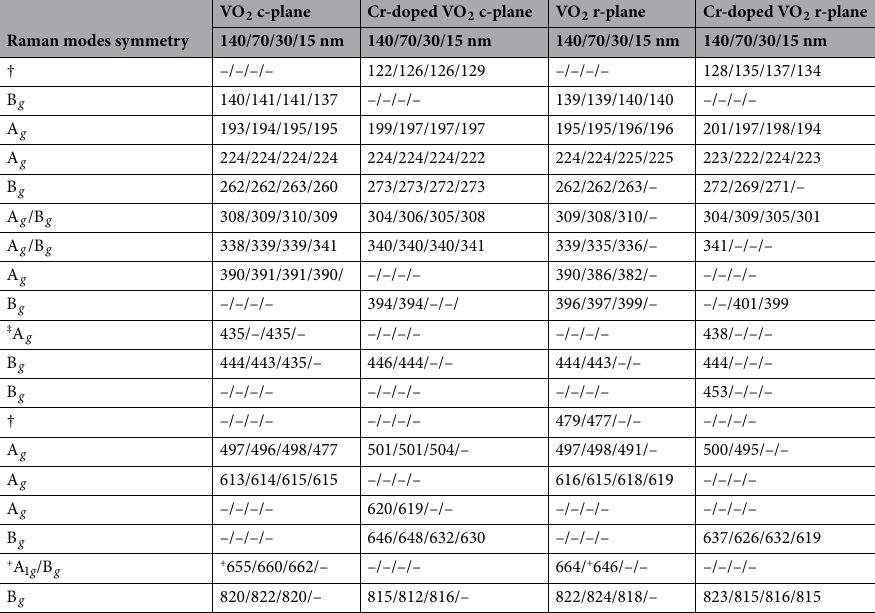
Table 2. Observed room-temperature phonon frequencies of undoped and Cr-doped VO 2 on c- and r-plane sapphires for thicknesses of 140, 70, 30 and 15 nm 46 . † Raman mode symmetry not yet assigned in literature; ‡ Raman mode symmetry assigned as A g by Aronov et al. 56 ; + Raman mode symmetry assigned as A 1 g by Srivastava et al. 42 ; and – no peaks